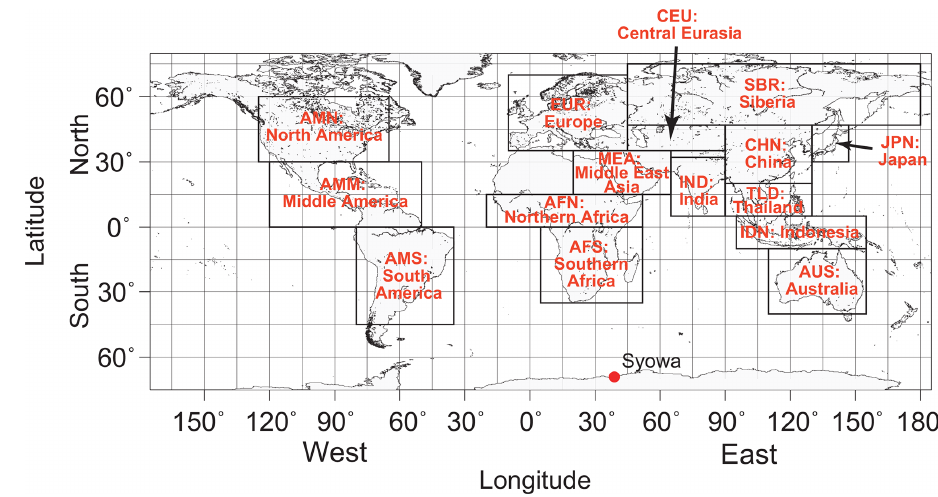
Figure 2. Regional separation for BC tracer tagging. The red circle represents the location of Syowa Station, Antarctica.